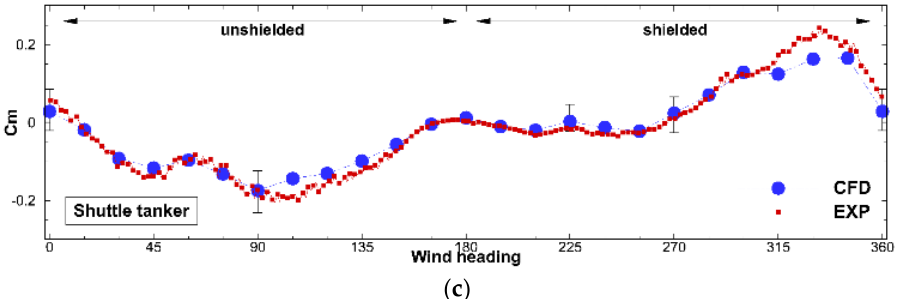
Figure 18. Comparison of aerodynamic coefficients for the shuttle tanker in the side-by-side configuration (4 m gap). ( a ) 𝐶 𝑥 ; ( b ) 𝐶 𝑦 ; ( c ) 𝐶 𝑚 .